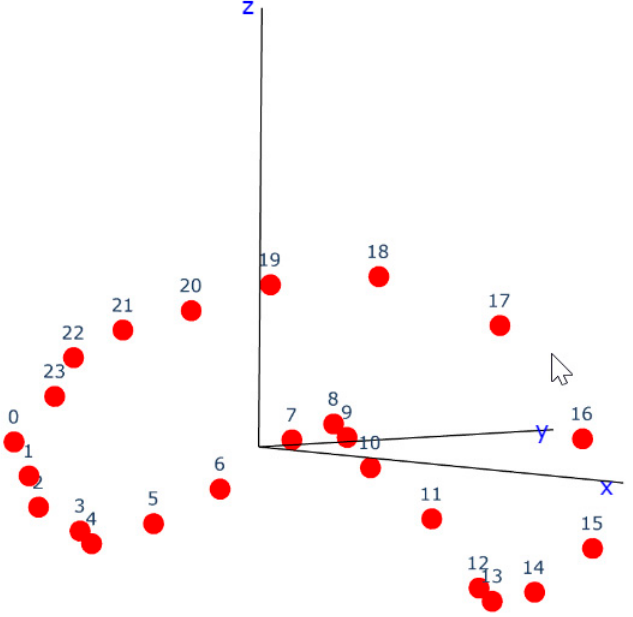
Figure 14. Hours in the embedding space.